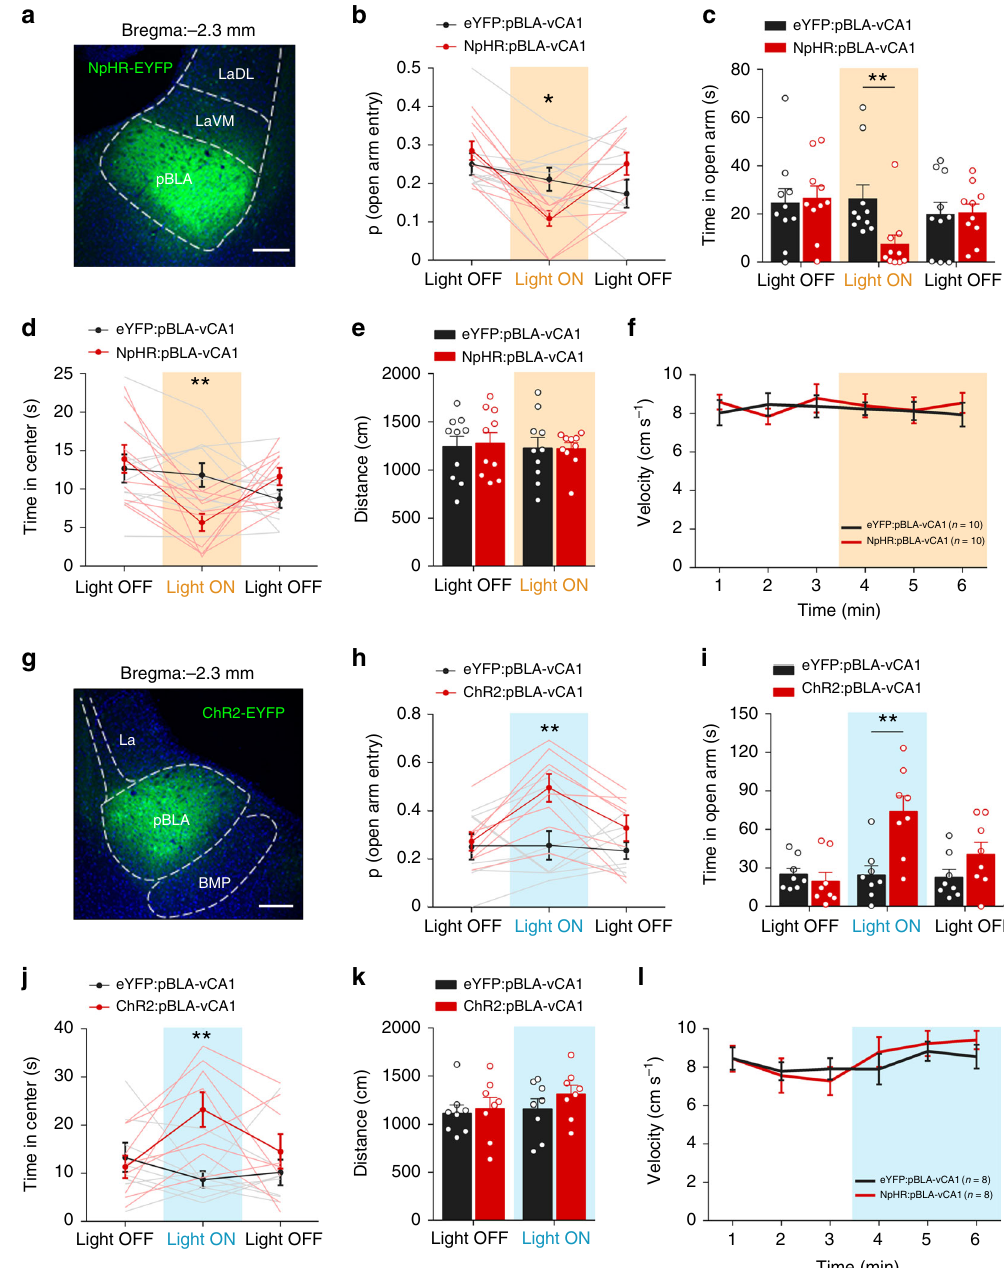
Fig. 2 pBLA – vCA1 inputs promote approach behaviour and exert anxiolytic effects. Representative confocal images con fi rmed the expression of NpHR ( a ) and ChR2 ( g ) in the pBLA. Scale bar, 200 μ m. NpHR ( b – d ) and ChR2 ( h – j ) mice were tested in a single 9 min session in the EPM ( b , c , h , i ) or the OFT ( d , j ) with three 3 - min epochs. b , c During the illumination epoch in the EPM, pBLA – vCA1 NpHR-eYFP optogenetic terminal stimulation decreased